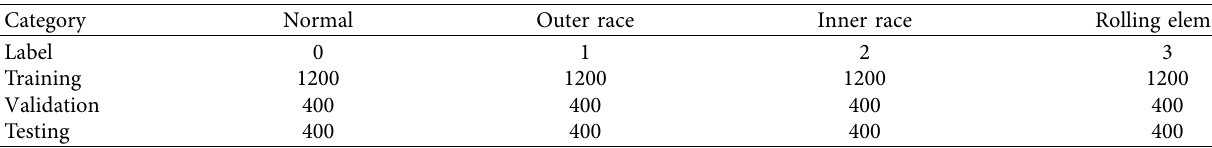
Table 3: Samples in the Jiangnan